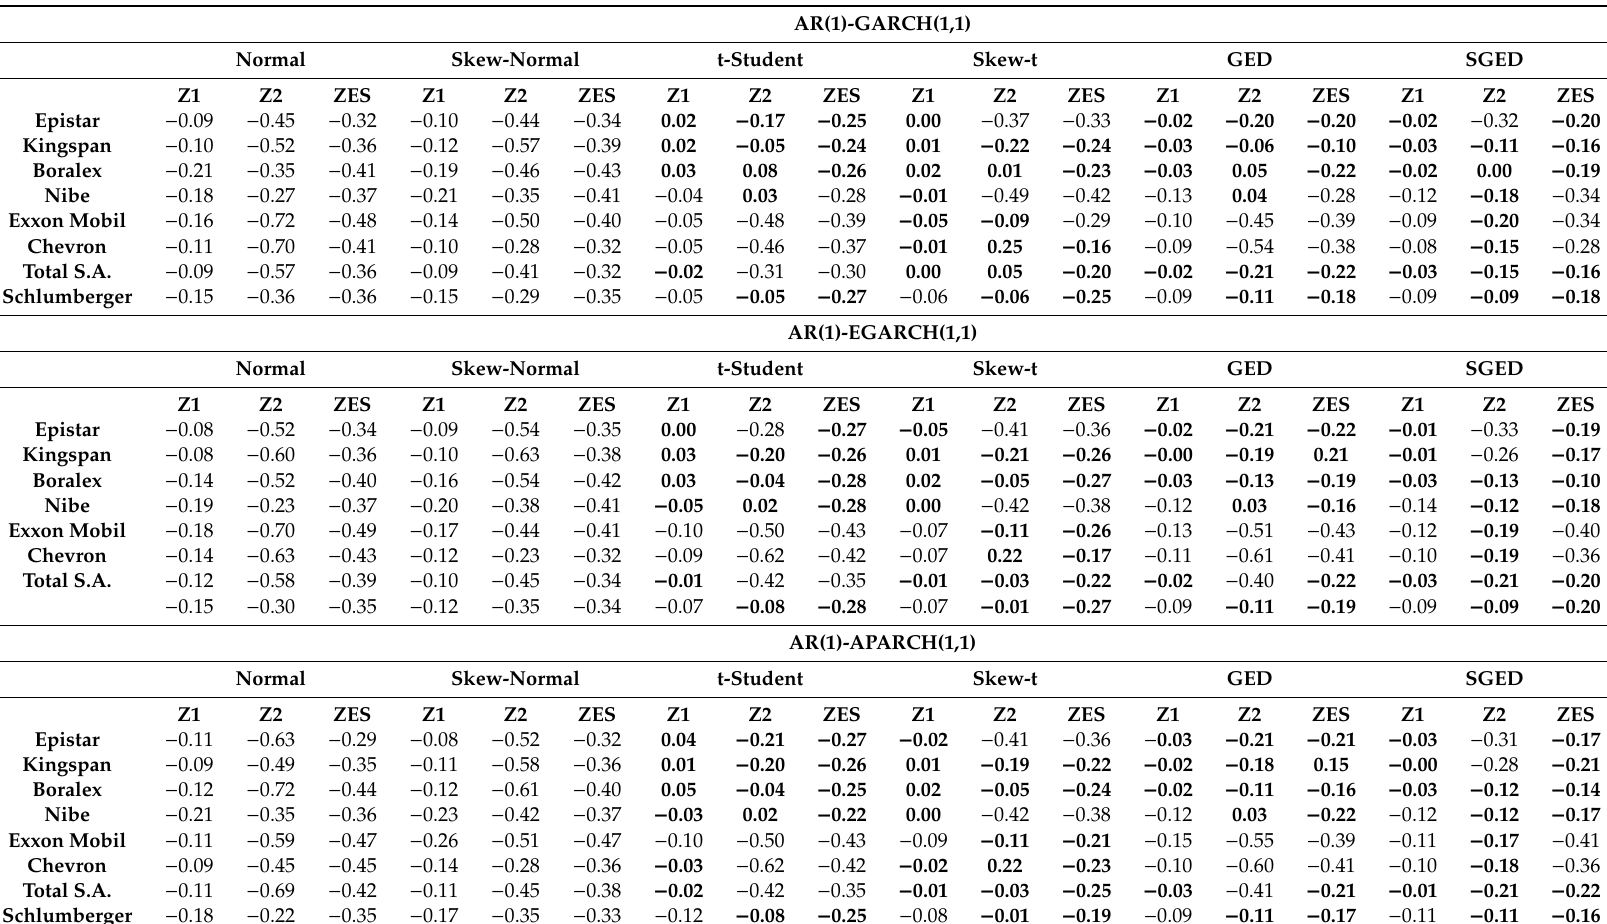
Table 5. 97.5%-ES backtesting. Values for Z 1 , Z 2 y Z ES